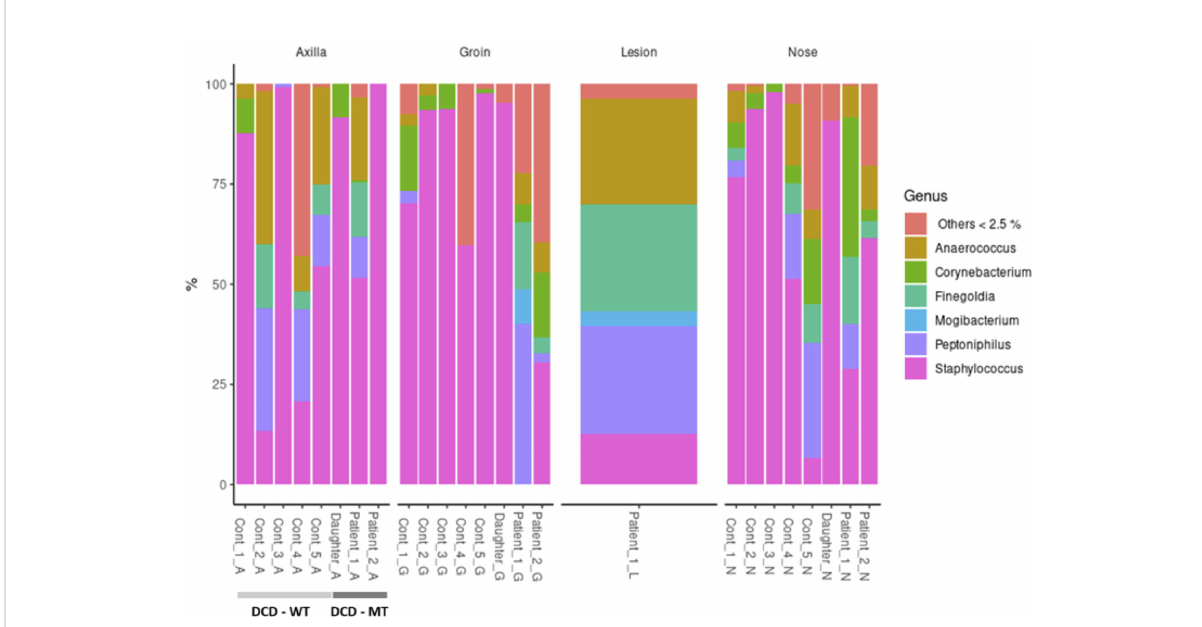
FIGURE 7 Taxonomic assignment of the most common genera (expressed as relative abundances) of study population (DCD-MT) samples versus healthy controls (DCD-WT) and strati fi ed according to the anatomical site.